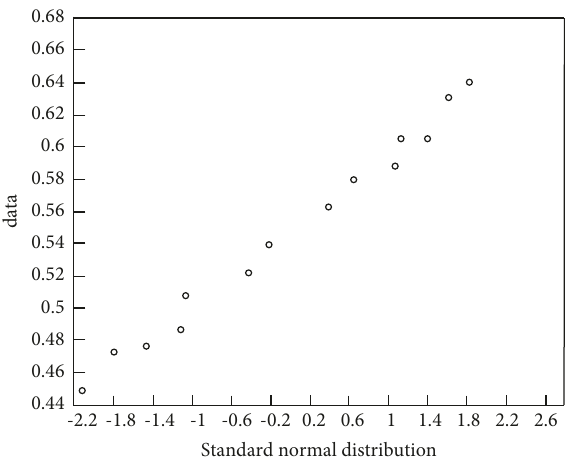
Figure 5: Q-Q plot of land price at sample